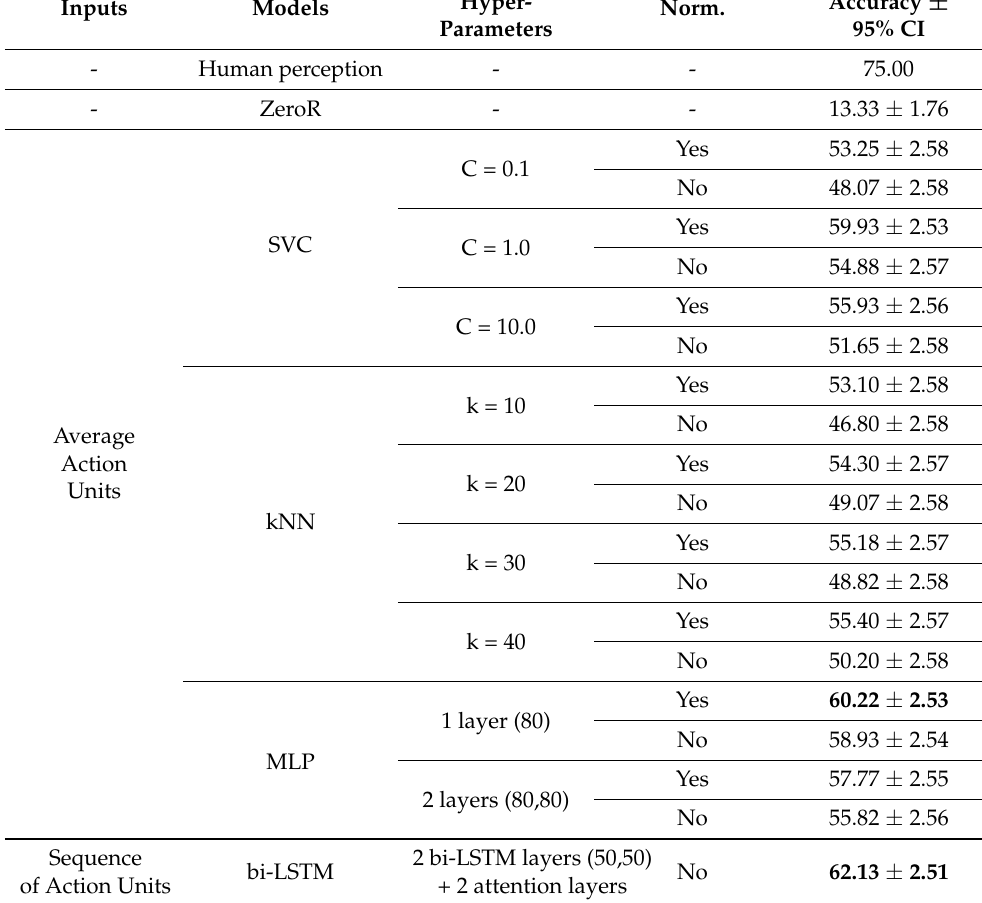
Table 2. Quantitative evaluation of the different strategies applied for the facial emotion recognizer. In bold, the best models per input